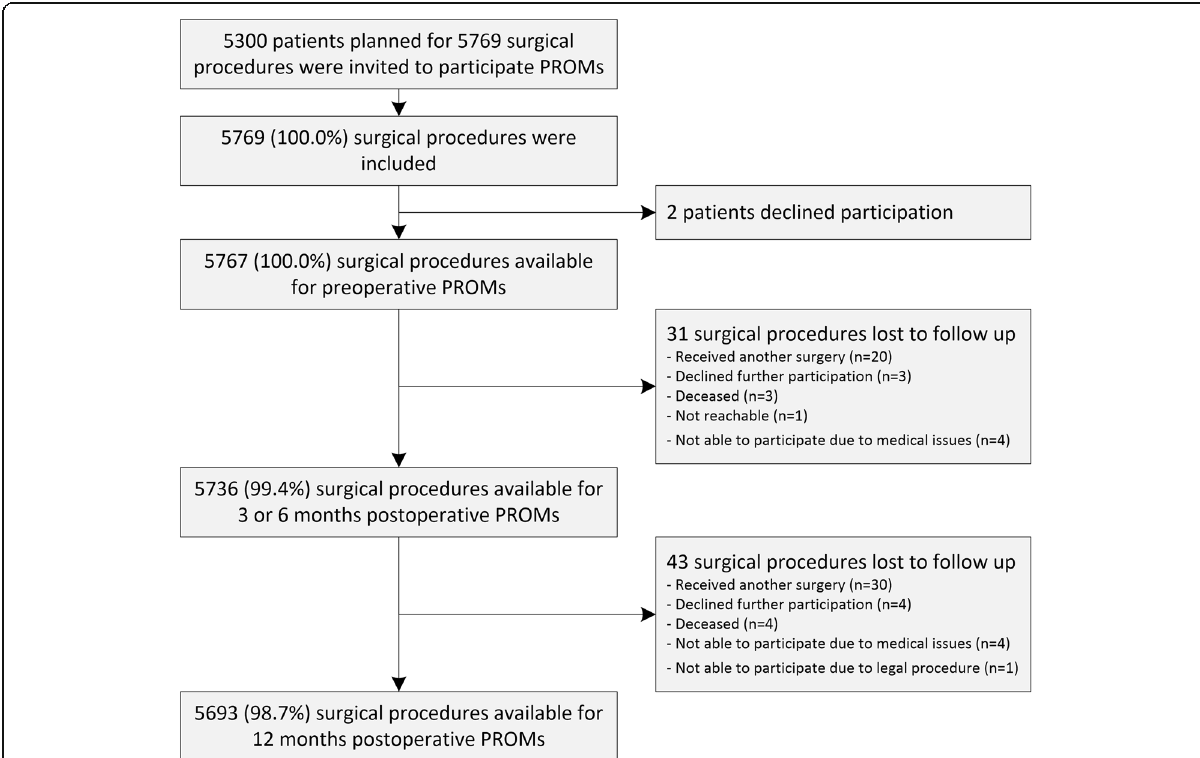
Fig. 1 Flowchart . Note : PROMs indicates patient-reported outcome measurements. n indicates